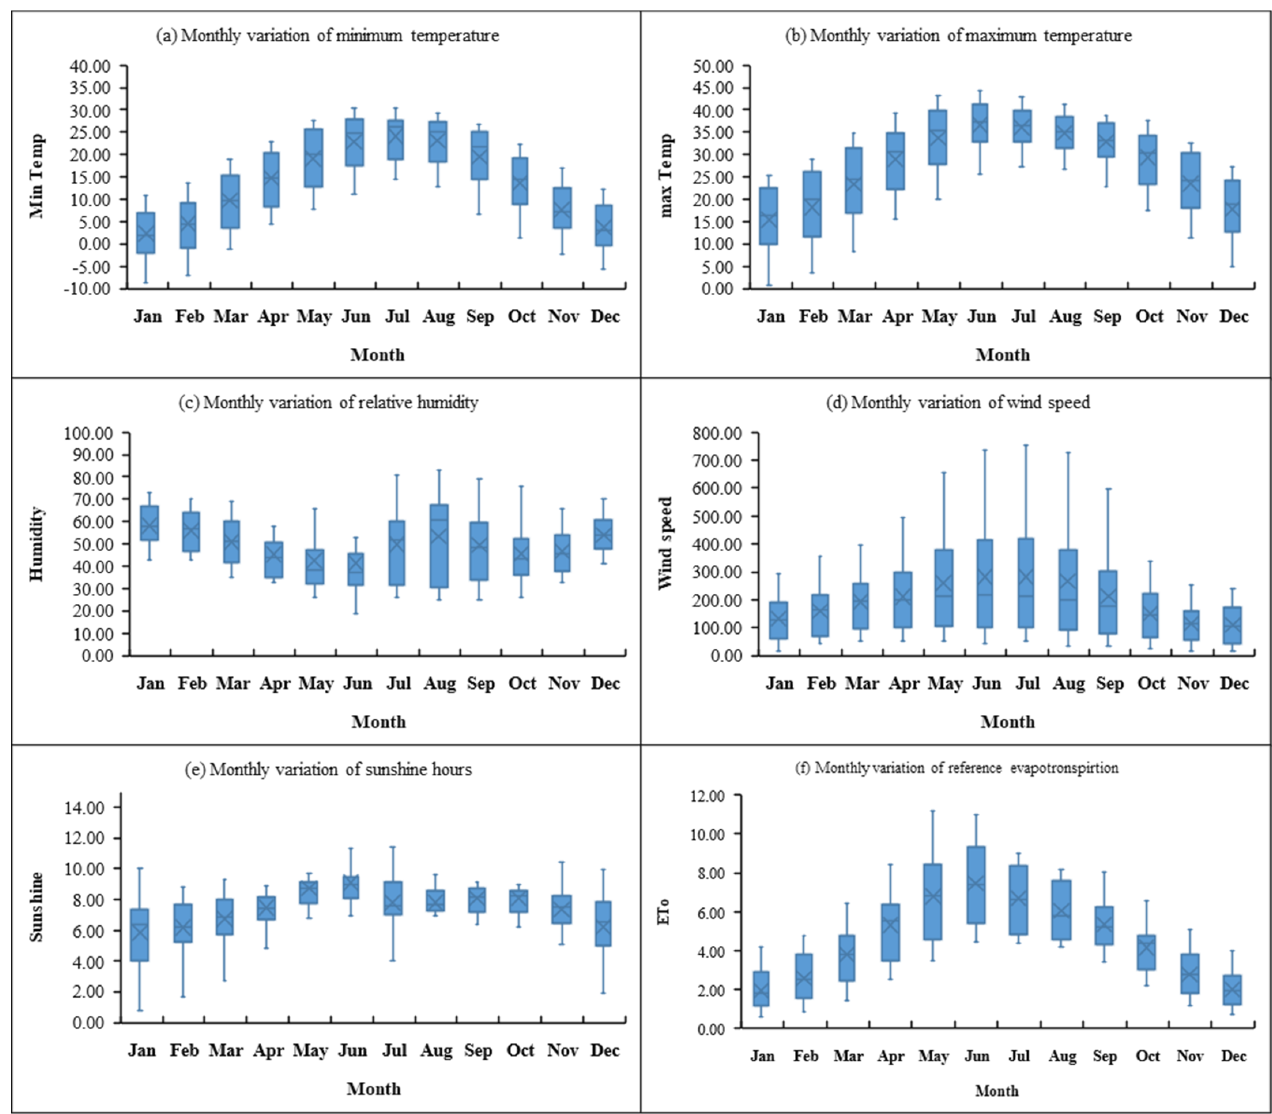
Figure 2. Boxplot shows monthly variations of the selected climatic variables. It can also be perceived from Figure 2 that T min increased from January to July and then continuously decreased until December. A similar trend was observed for T max (Figure 2b). This is because of the solar effect from winter to summer seasons (Figure 2e). N observed the maximum during the summer and the minimum when winter started. In addition, RHavg was interconnected with T max and T min because the maximum humidity was observed when the air temperature was high and vice versa. Moreover, RH avg was the highest in the summer season (Jul to Sep) because of the wind effect (Figure 2c). When the wind blows higher in the summer, as observed in Figure 2d, it increases humidity in the air. Overall, the maximum increase in average humidity and the highest humidity value were observed in the summer